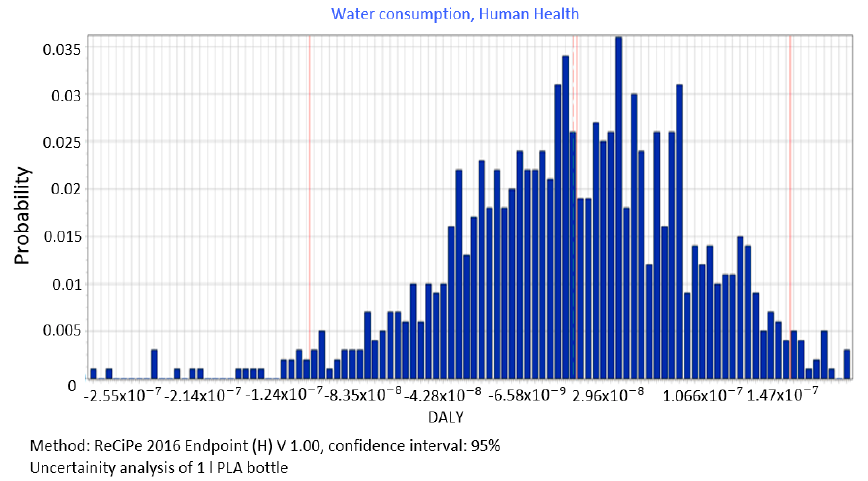
Figure 10. Results of the uncertainty analysis for the category of water consumption and its impact on human health.